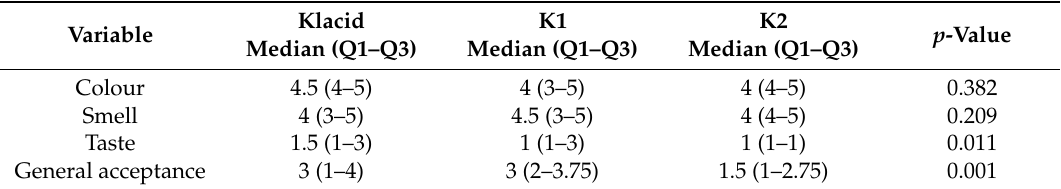
Table 2. Comparison between the three products based on in vivo pediatric evaluation of CM (125 mg/5 mL) suspensions. (Kruskal Wallis